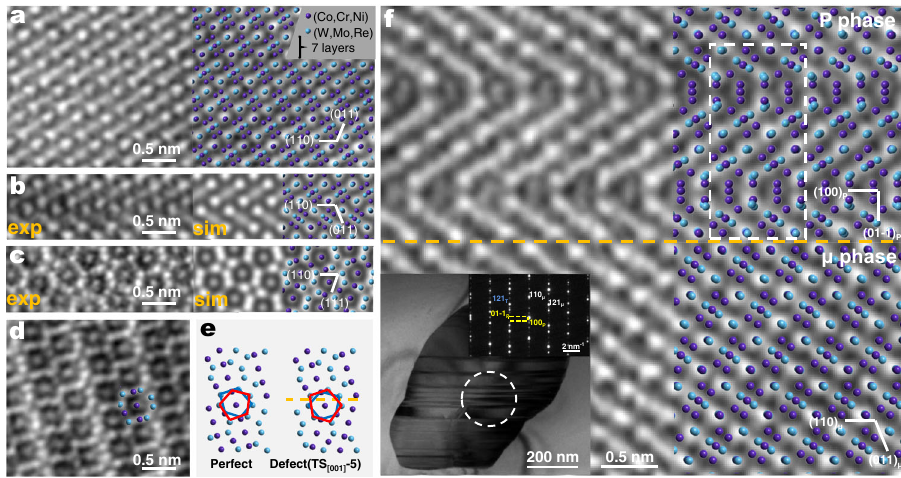
Fig. 1 The structure and atomic arrangement of the TCP phases and the intrinsic defect, the faulted twin boundary (FTB). a A HAADF image (left, [1-11] zone axis), in direct comparison with the schematic (right) of μ phase with seven nonequivalent (110) layers. Note that the hexagonal description is also often used for the rhombohedral μ phase. Some typical plane/orientation relationships are: (110) corresponds to (1-12) H , [1-11] corresponds to [42-1] H , and [1-10] corresponds to [110] H . Please refer to Supplementary Fig. 1 for details. b The left panel displays the experimental HAADF image of the [1-11] projection of (110) FTB; the inset displays the simulated HAADF image together with the schematic of the interface structure TS [001] -5. c The HAADF image (left) of (110) FTB observed along [1-10] μ and simulated HAADF images (right) of TS [001] -5 along this axis. d The HAADF image ([1-10] zone axis) of the μ phase, showing pentagonal con fi gurations. e The projected atomic arrangement of μ phase and the TS [001] -5 along [1-10] μ in which the pentagonal anti-prism structures are highlighted. f The HAADF image and the schematic of the P phase and μ phase, projected along [011] P and [1-11] μ , respectively; the boundary plane marked by orange dotted line between the two phases is (110) μ , parallel to (100) P . The white framed box marks the unit cell of the P phase. The lower left corner inset displays the bright- fi eld TEM micrograph and the corresponding SAED patterns of the two